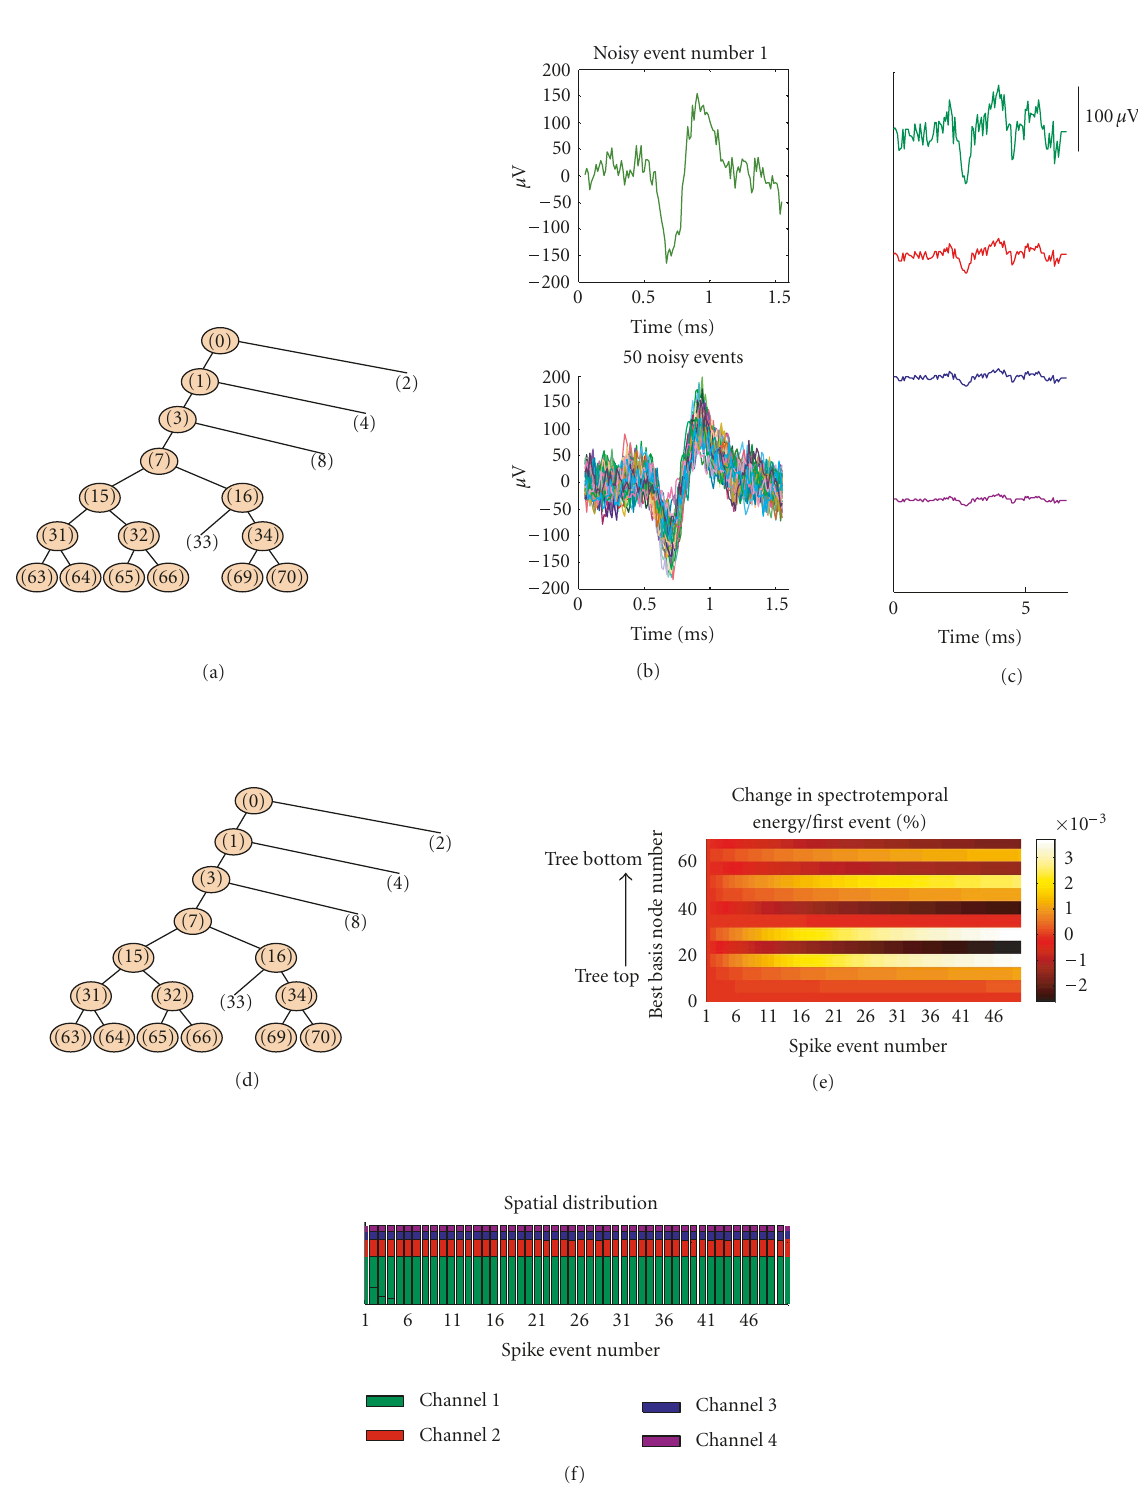
Figure 15: Tracking signal nonstationarity for an “attenuated-only” action potential of a bursting neuron. The largest amplitude spike is the first event. The events on channel 1 are superimposed in (a) and (b) for comparison. (c) Observed signal across a 4-channel array for event number 26. (d) Best basis tree set J 1 for each event. (e) The percentage change in eigenvalue λ l 1 ( k ) relative to λ l 1 (1) magnitude across the best basis set. The circled nodes are the best subbands were the spike waveform is represented, and the combination of positive and negative eigenvalues magnitudes changes in (e) is interpreted as a smooth migration of the spike projection from one node (where the change is negative) to other nodes (where the change is positive). In the later, the spike projection becomes stronger despite the loss of energy in the time domain